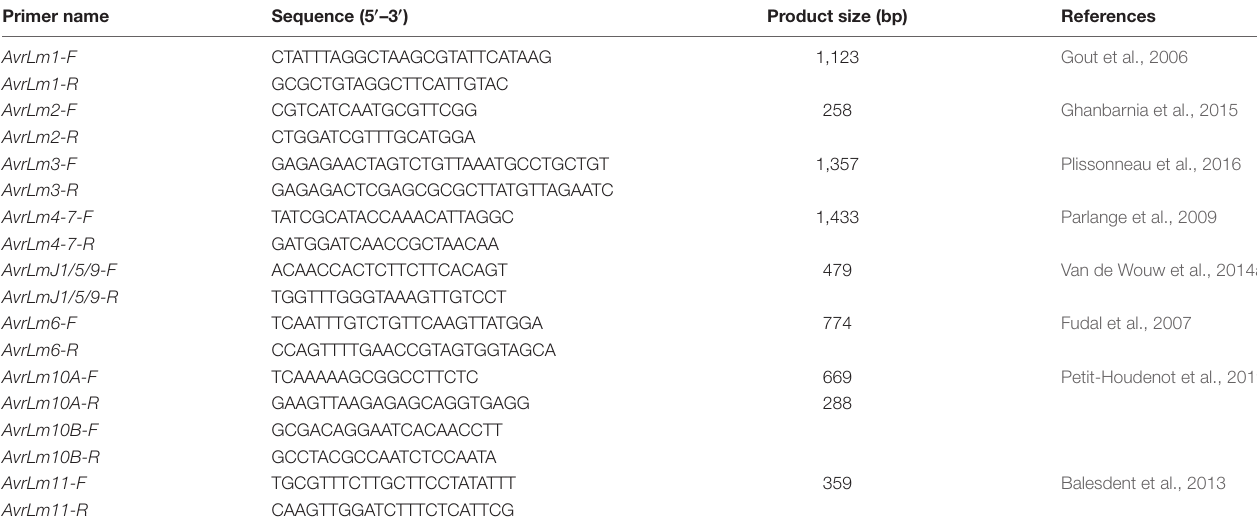
TABLE 2 | Primer name, sequence, product size, and source of avirulence allele primers used in PCR